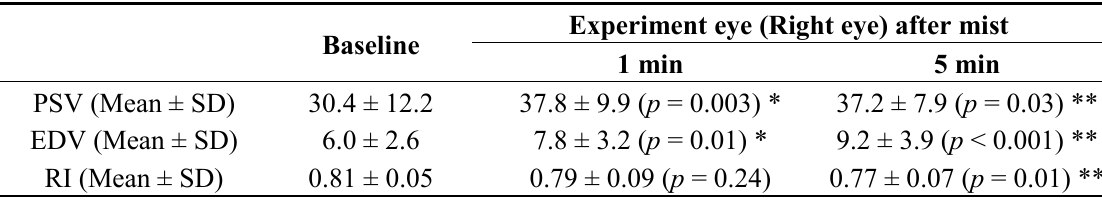
Table 1. Stage 1: Baseline and mist comparison after 1 min and 5 min.